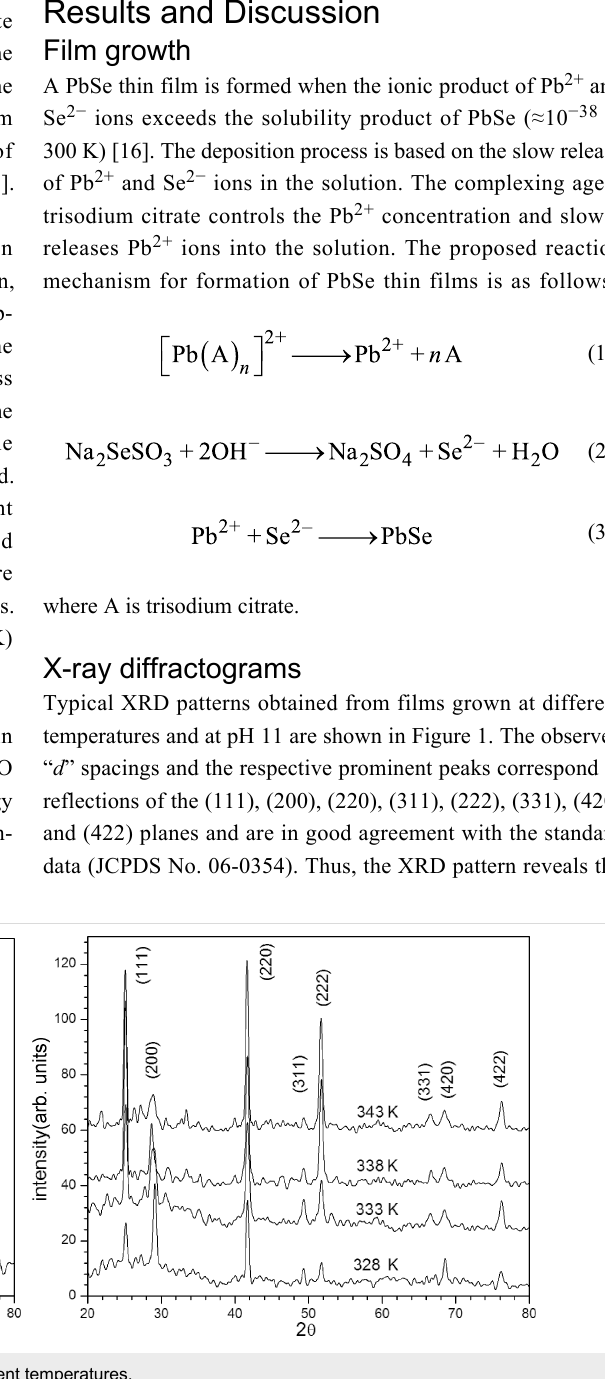
Figure 1: X-ray diffraction patterns of PbSe thin films prepared at different